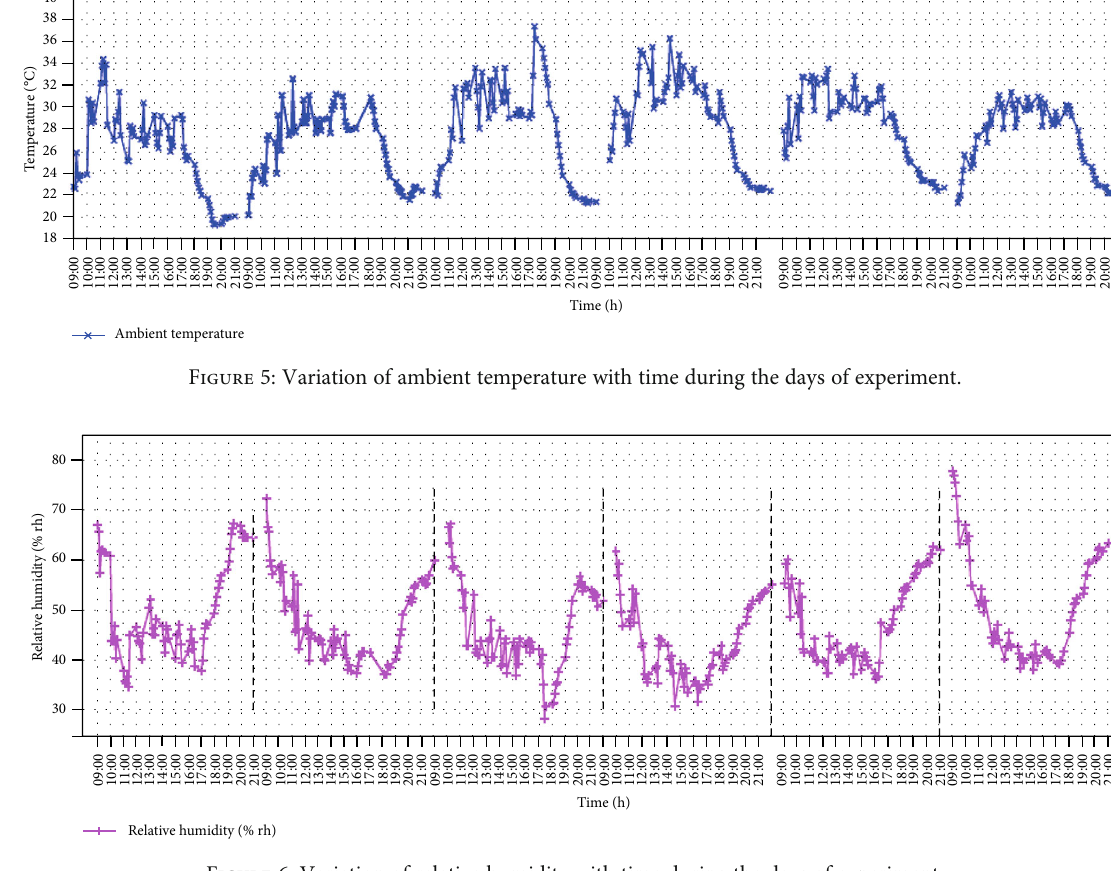
Figure 6: Variation of relative humidity with time during the days of experiment.